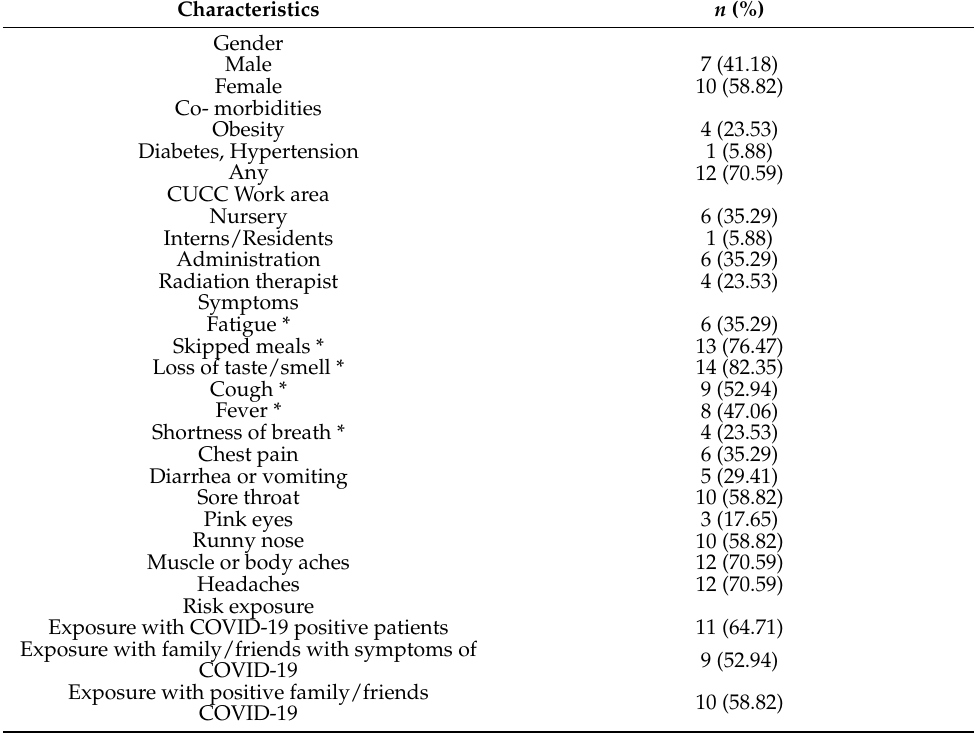
Table 1. Epidemiological characteristics of 17 O.M.S./qRT-PCR positive for SARS-CoV-2 identified with the algorithms ( n = 17).